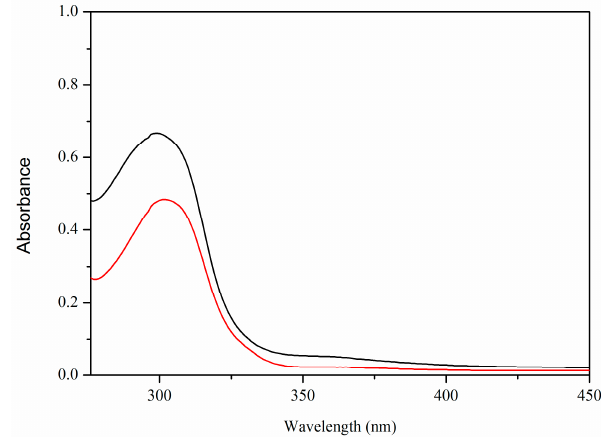
Figure 5. The UV-Vis spectra of 3,5-bis(4-pyridylmethoxy)benzoic acid (HL) and [CaL 2 (H 2 O) 2 ] n ·HL ligand (red) and Ca(II) complex (black).